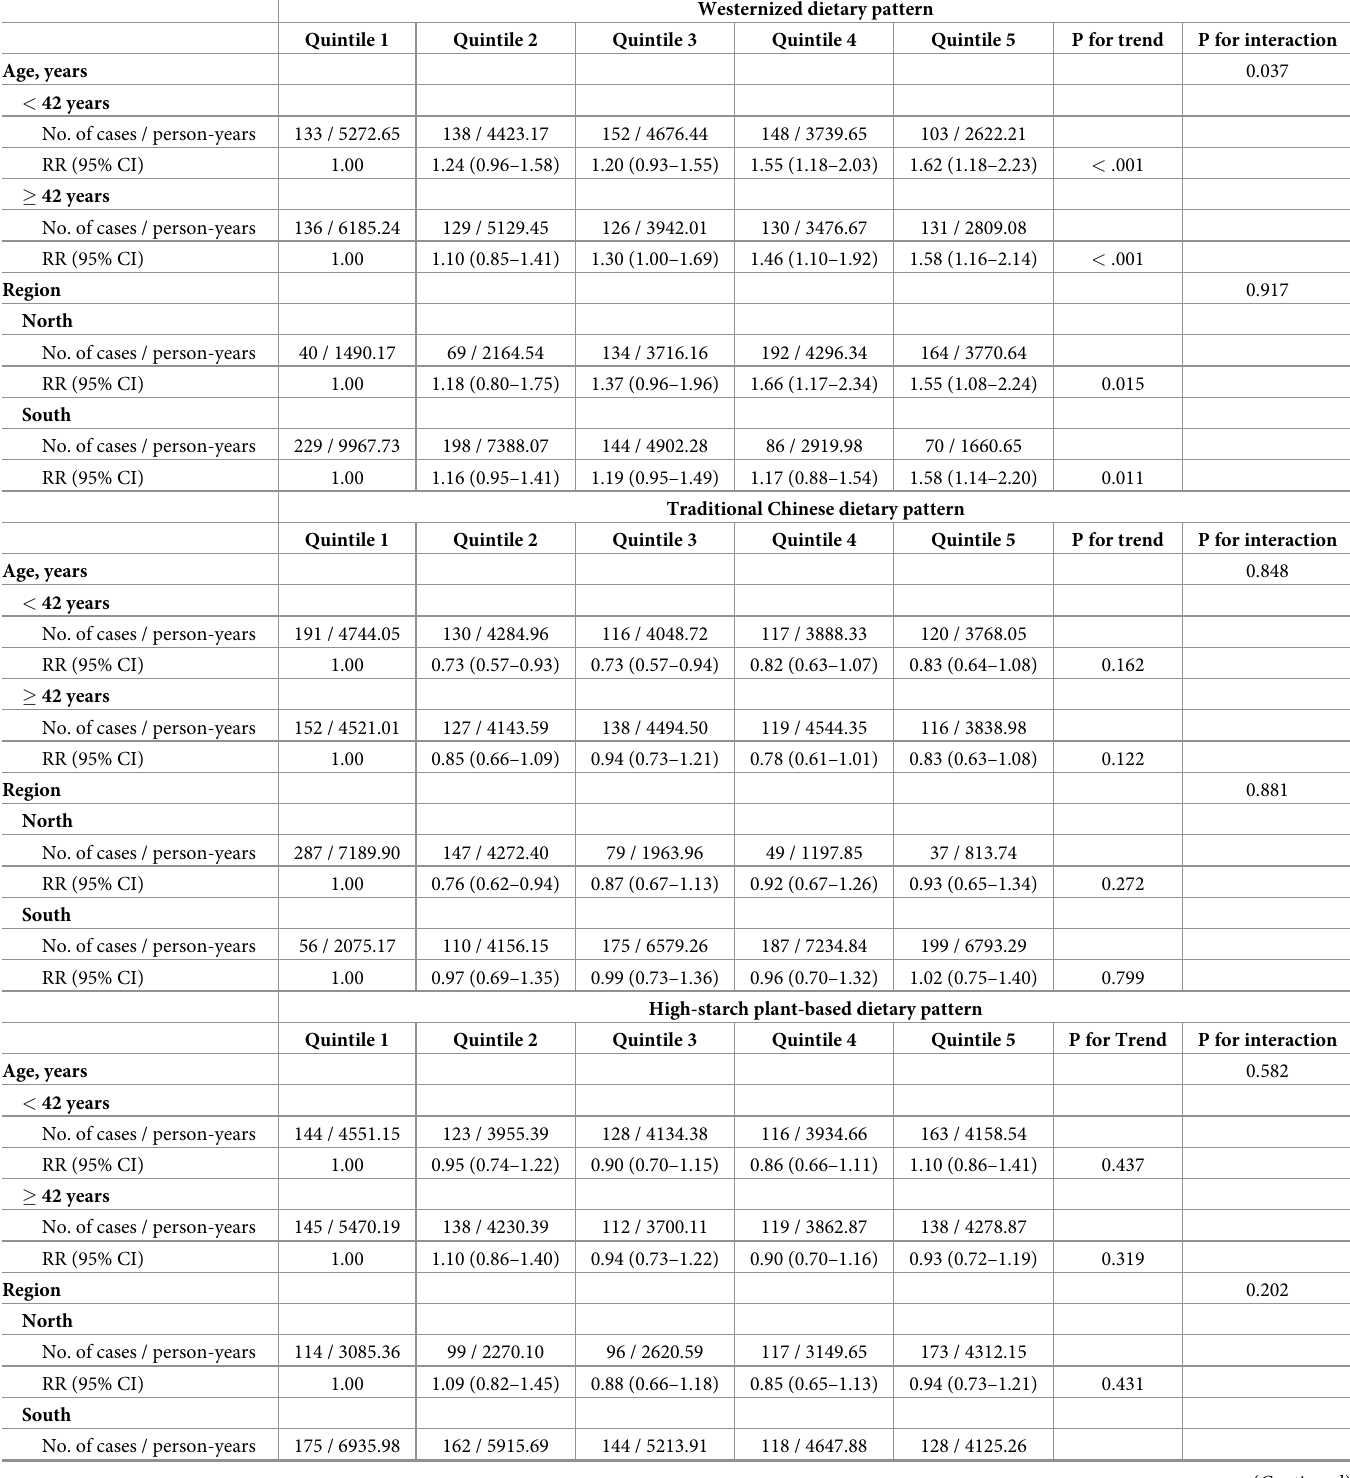
Table 4. Relative risk (RR)s a of incident obesity (BMI � 25kg/m 2 ) according to quintiles of dietary patterns by age and